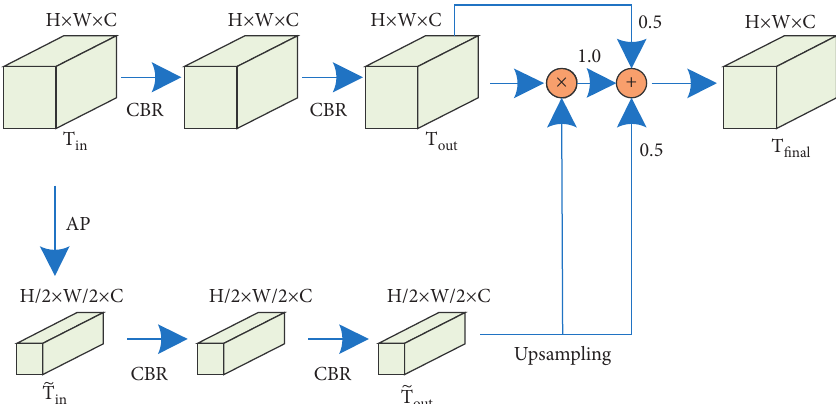
Figure 3: Multiscale feature extraction unit; CBR is composed of convolution, batch normalization, and ReLU operation; AP denotes average pooling.